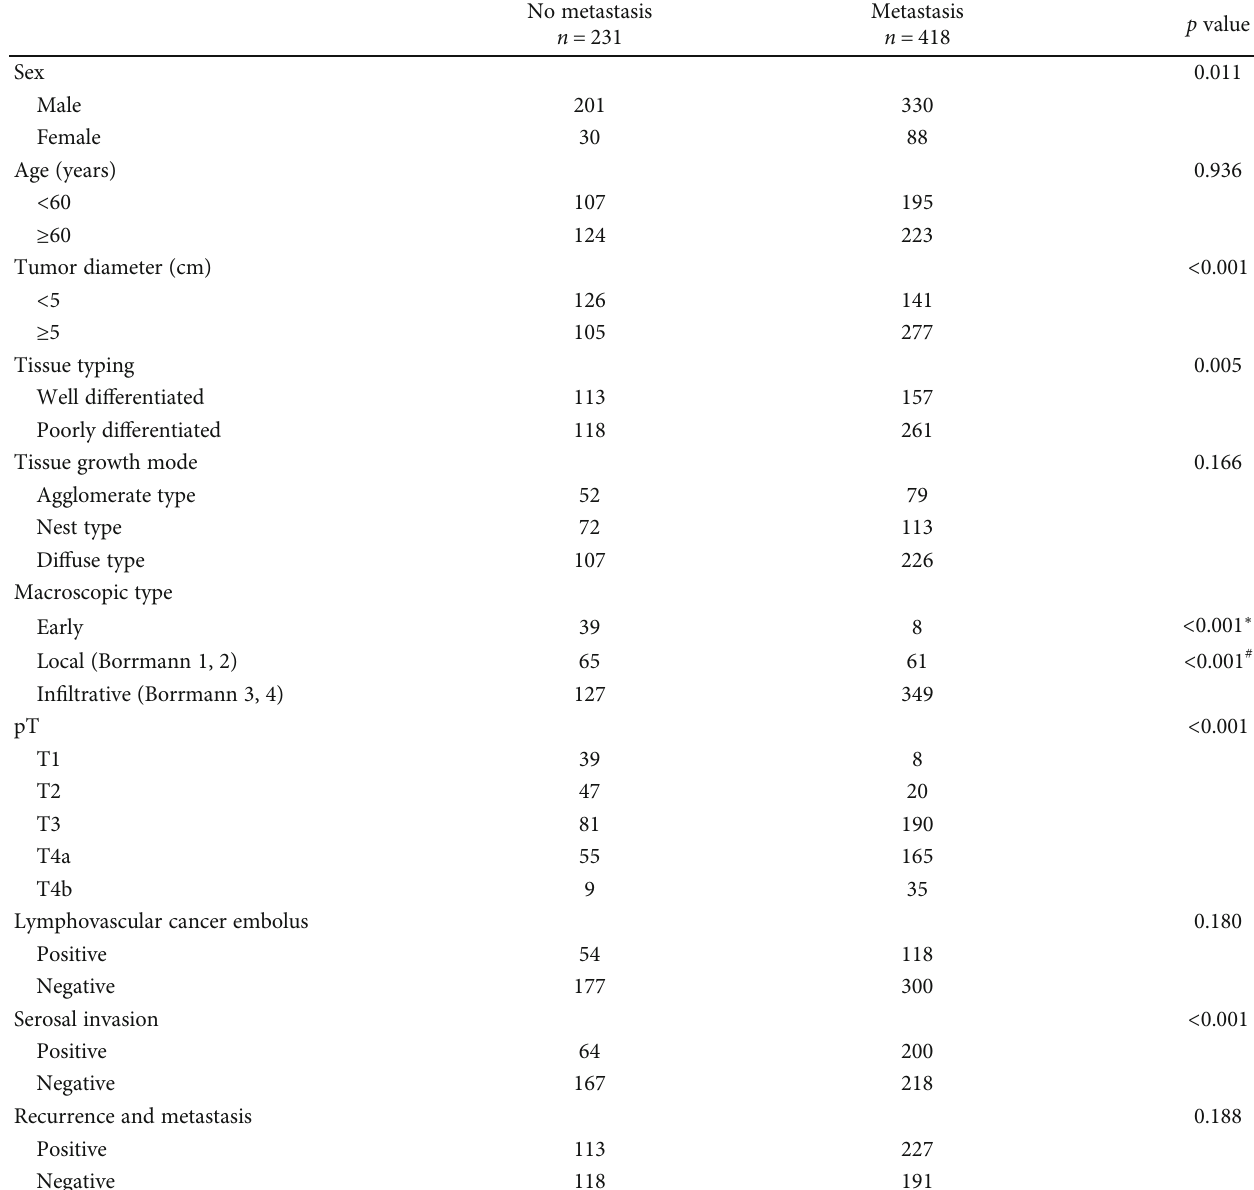
Table 3: Patient characteristics and lymph node metastasis of upper gastric